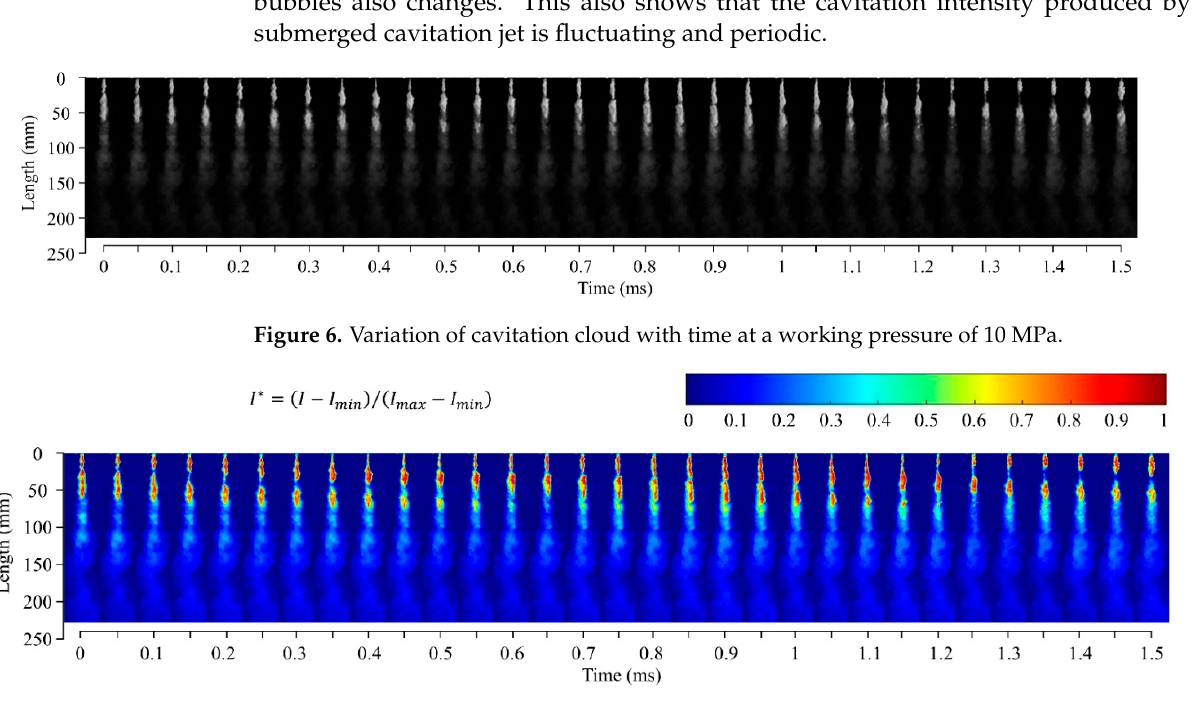
≤ 0.03 Table 3. Physical properties of the samples. Density /kg ∙ m 3